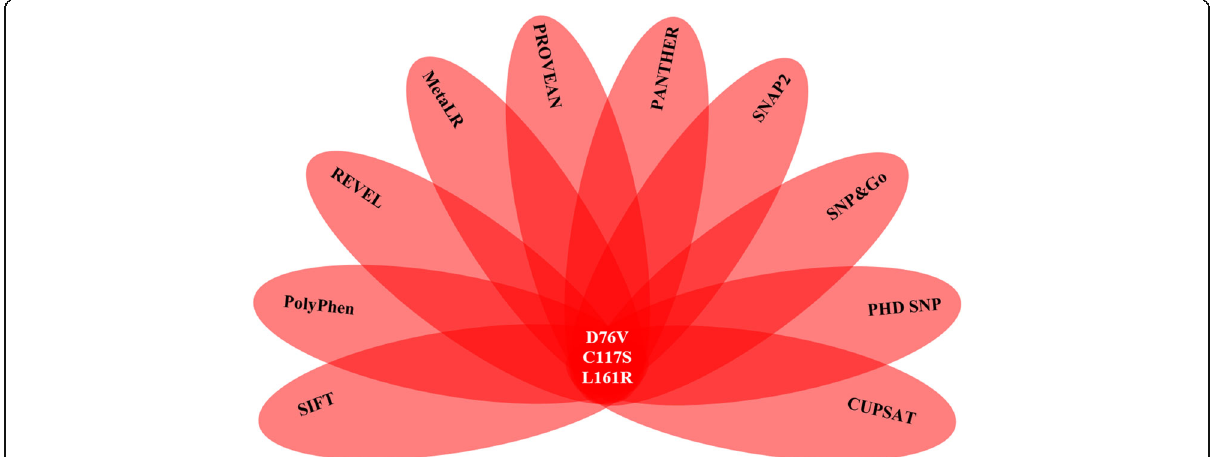
Fig. 1 Ten different computational tools utilized to predict the most deleterious effect of amino acid substitutions on leptin structure, function, and stability. These tools cumulatively showed that the most deleterious substitutions are D76V, C117S, and L161R